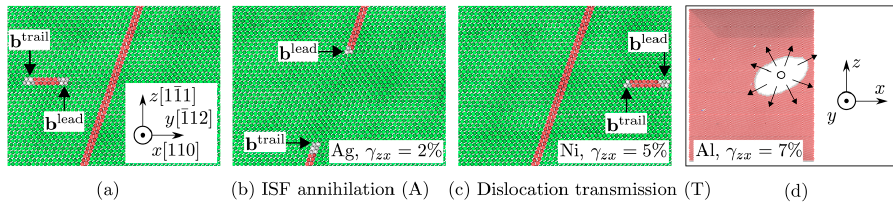
Figure 4. Atomic configurations of ( a ) a screw dislocation approaching the ISF (reaction 1) and range of observed reactions that includes ( b ) annihilation of the ISF (A, reaction 3) and ( c ) transmission of the screw dislocation across the ISF (T, reaction 1). In ( a – c ), the Burgers vectors of the leading (lead) and trailing (trail) partial dislocations are given in the corresponding reactions. The applied shear strain γ zx is zero in ( a ). ( d ) Shear-induced annihilation of the ISF in the absence of an incoming lattice dislocation; specifically, the restoration of the perfect lattice arrangement is initiated within the ISF (open circle) and spreads out across the ISF (arrows). Atoms are colored in the same way as in Figure 2a–c, which possess the same orientation (shown in ( a )), while ( d ) shows a different view with all FCC atoms